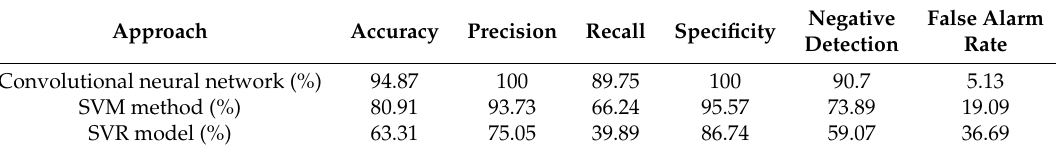
Table 31. Comparison of detection evaluation indices among the three methods for converter faults.